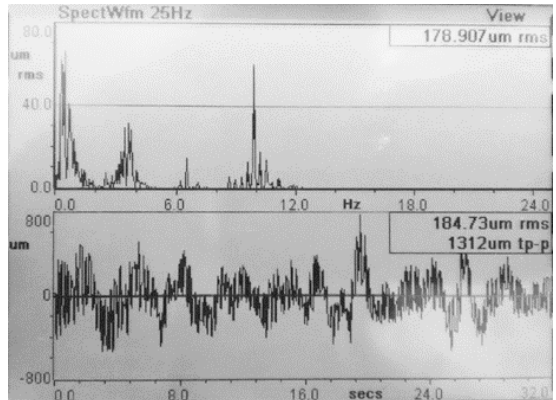
Figure 15. Amplitude–frequency spectrum of structure vibrations.